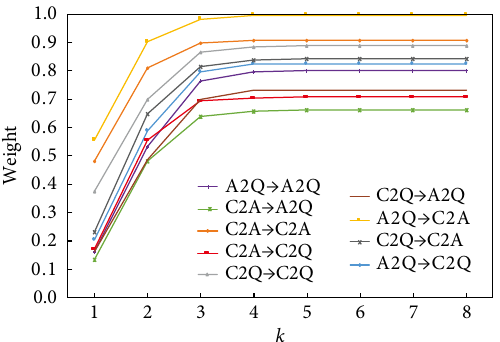
Fig. 8 Experimental result on the Math-Overflow dataset.